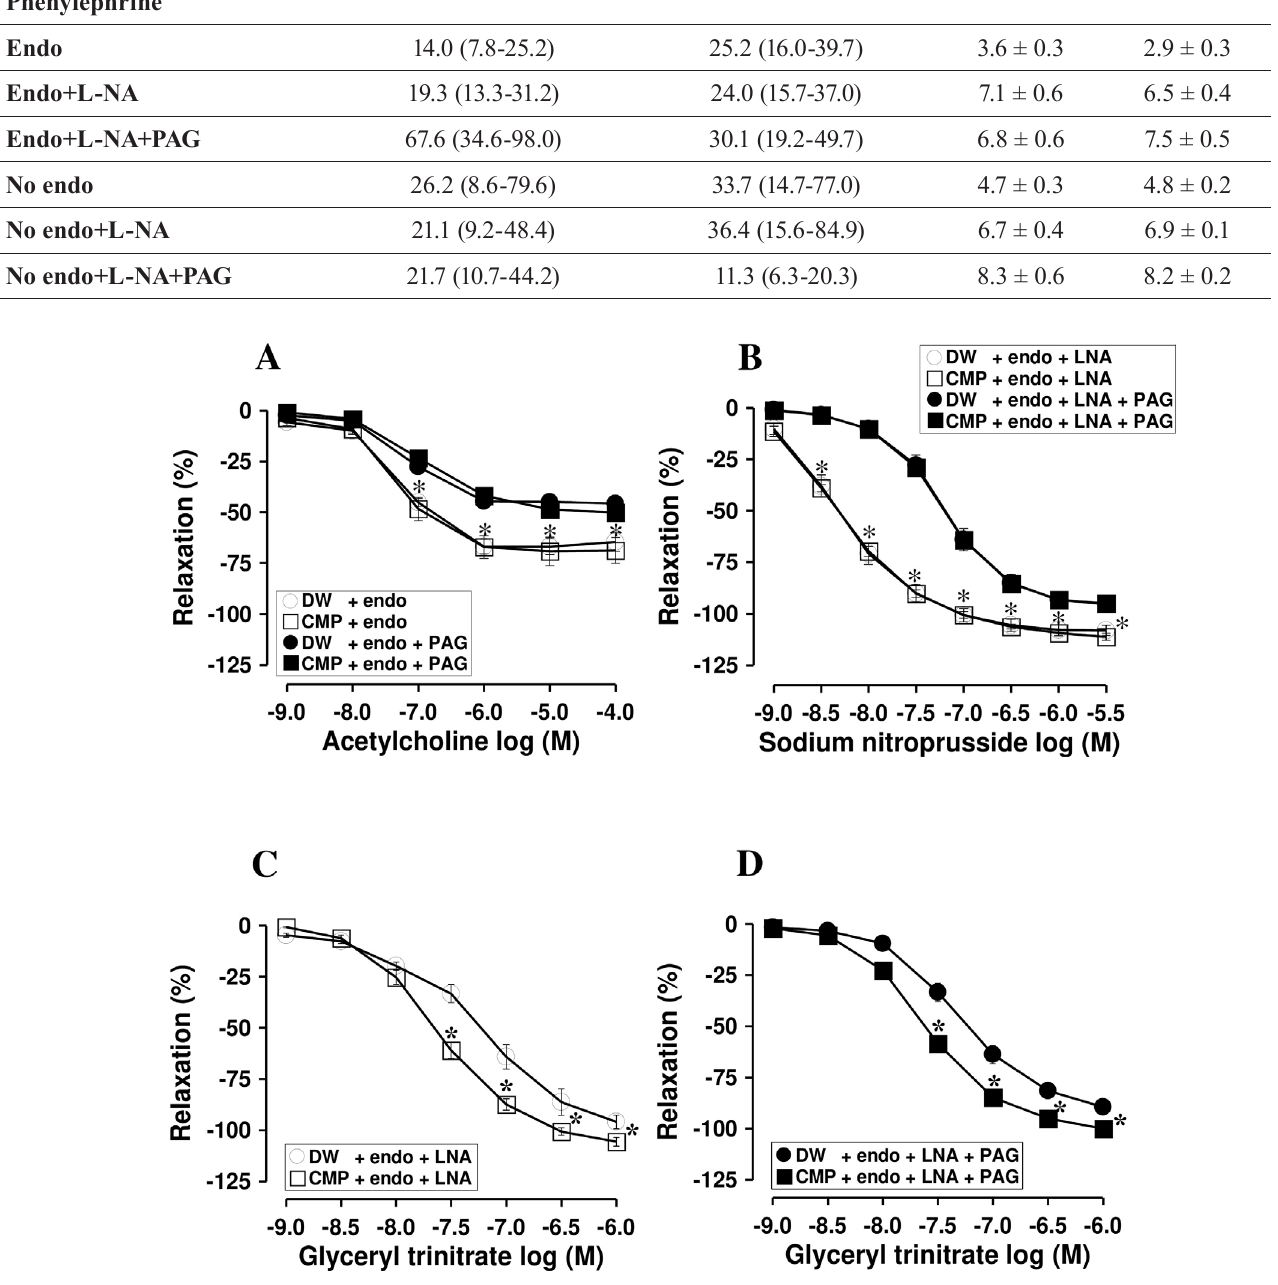
FIGURE 6 - Effects of CMP (1 g/kg) or distilled water (DW, control) consumption by the middle-aged male rats on relaxation of the endothelium-intact thoracic aortic ring precontracted with phenylephrine to acetylcholine (A), to sodium nitroprusside (B), to glyceryl trinitrate (C) or to glyceryl trinitrate in the presence of L-NA and PAG (D). Values represent mean ± SEM; n = 6. * Significantly lower than the DW control group, P <